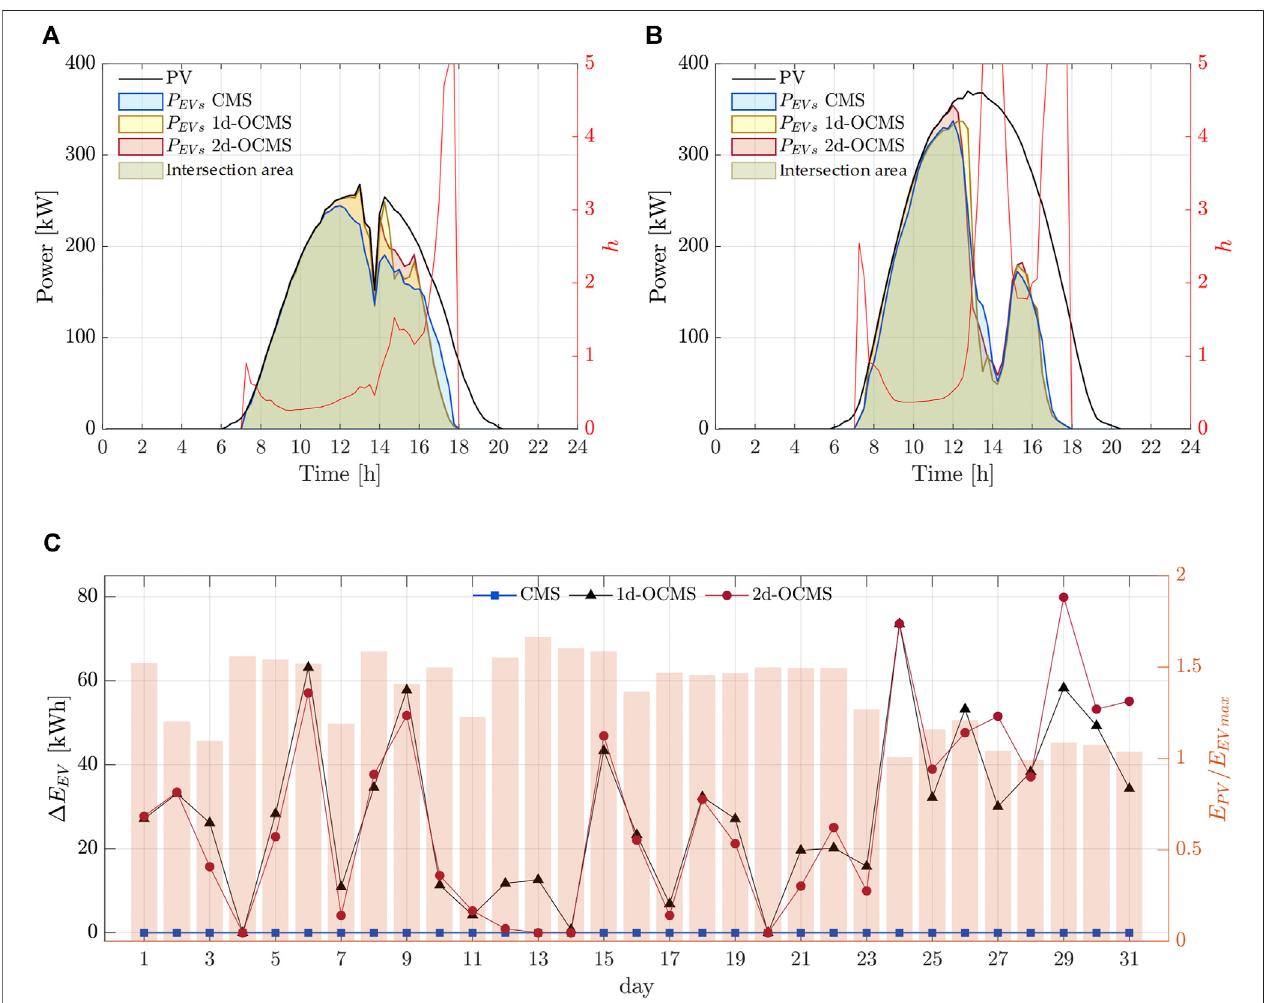
FIGURE12 | Daily evolution of h -factor (red line), PV(blackline) power, and EVs charging power in case ofstandard CMS (light blue area), 1d-OCMS (yellow area), and 2d-OCMS (red area) in case of E PV / E EVmax (cid:3) 1 (A) and E PV / E EVmax (cid:3) 1 . 5 (B) . The intersection area is displayed in green color. (C) Daily energy gap Δ E EV (left-hand axis) and E PV / E EVmax ratio (right-hand axis bar chart) over a 31-day evaluation.